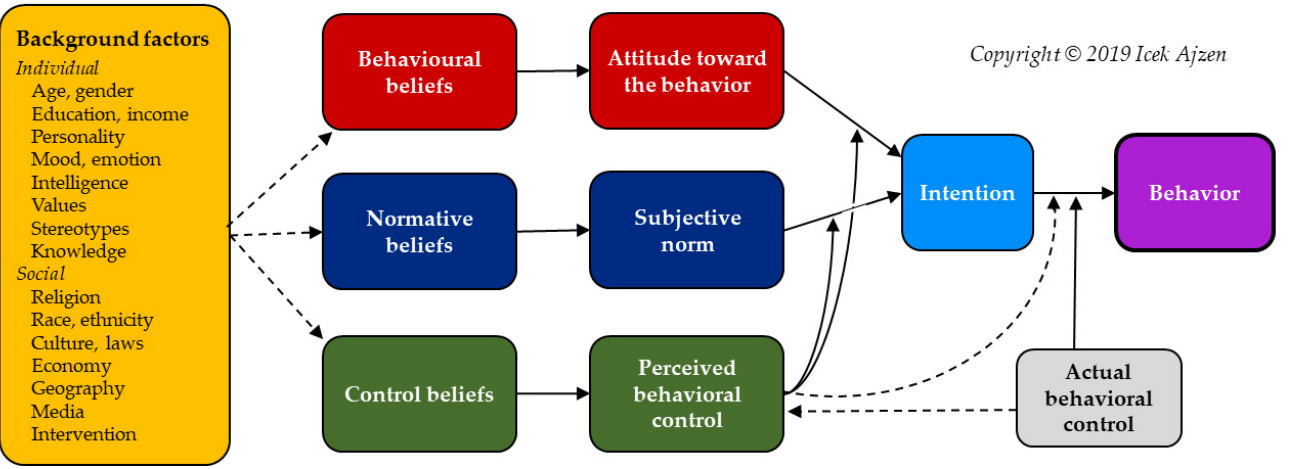
Figure 1. Icek Ajzen’s Theory of Planned Behaviour (TPB) with background factors was used to organise the thematic analysis. Reproduction of this figure is permitted in journal articles, as stated on the University of Massachusetts website from which it is sourced: https://people.umass.edu/ aizen/tpb.background.html (accessed on 12 July